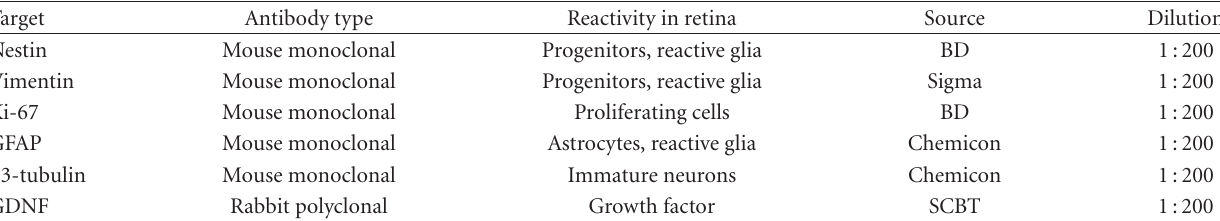
Table 2: Primary antibodies used for immunocytochemistry on